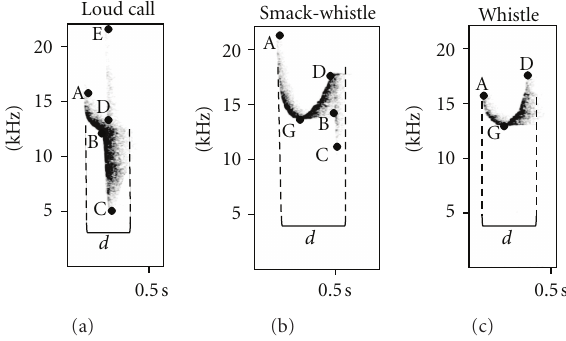
Figure 4: Parameters measured for analyses of loud calls, smack- whistles, and whistles. In points (A–E) indicated in the spectro- grams, frequency and time parameters were measured and used for calculating additional parameters. For analyses of loud calls, we used start F (A frequency), bend F (B frequency), min F (C frequency), middle F (D frequency), whistle FM (A-B frequency modulation), smack FM (B–C frequency modulation), centre FM (B–D frequency modulation), whistle duration (A–D duration), smack duration (B–C duration), centre duration (B–D duration), and duration (d). For analyses of smack-whistles and whistles, the following parameters were used: start F (A frequency), second peak F (D frequency), bottom F (G frequency), 1st part FM (A–G frequency modulation), 2nd part FM (G–D frequency modulation), whole FM (A–C frequency modulation) (only in smack-whistles), 1st part duration (A–G duration), 2nd part duration (G–D duration), whistle duration (A–D duration), and duration